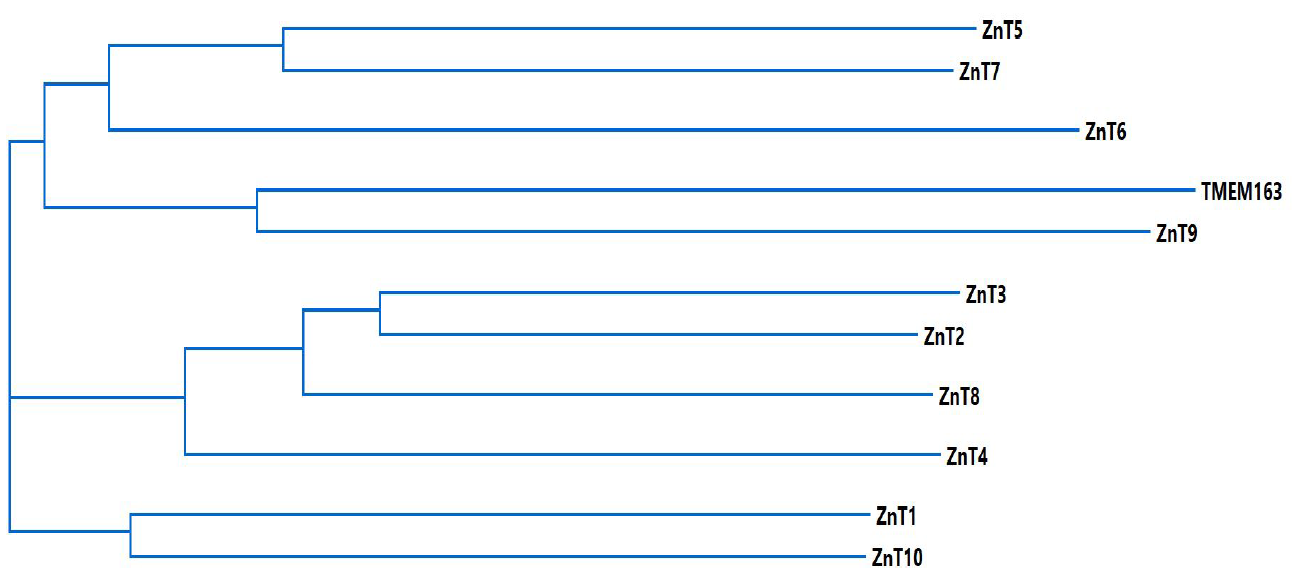
Figure 2. Cladogram of TMEM163 and ZnT family members. The multiple sequence alignment and phylogenetic tree were calculated using Clustal Omega (Lasergene v17.1 MegAlign Pro; DNAStar, Madison, WI, USA). Full-length amino acid sequences were obtained from the UniProt website: TMEM163 (Q8TC26); ZnT1 (Q9Y6M5); ZnT2, (Q9BRI3); ZnT3 (Q99726); ZnT4 (O14863); ZnT5 (Q8TAD4); ZnT6 (Q6NXT4); ZnT7 (Q8NEW0); ZnT8 (Q8IWU4); ZnT9 (Q6PML9); and ZnT10 (Q6XR72).